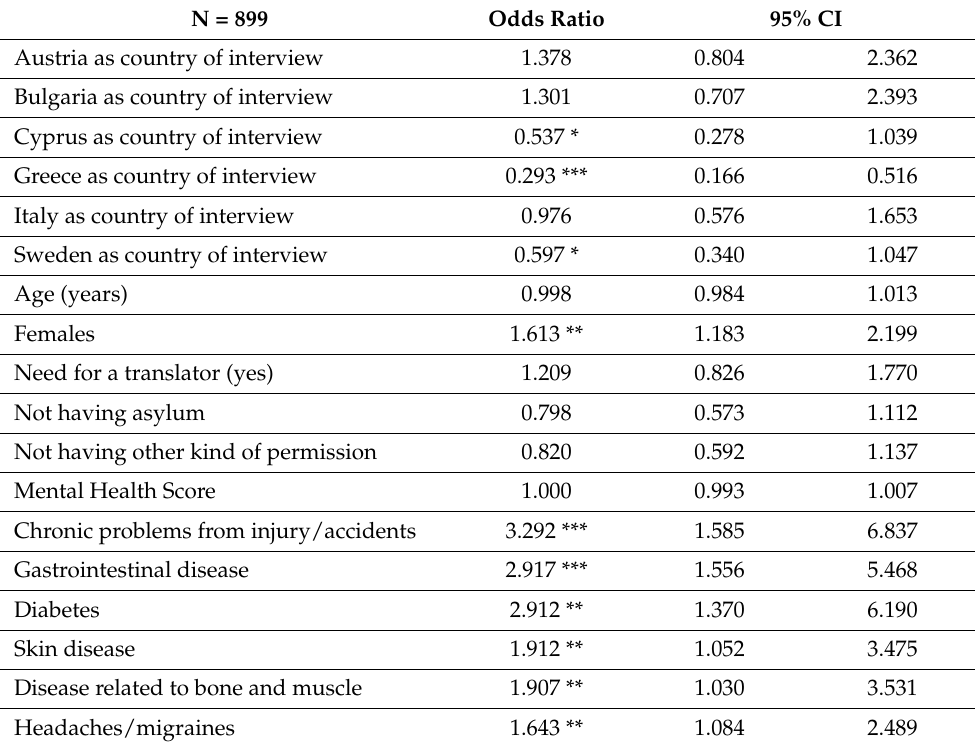
Table 7. Multivariable logistic regression investigating the impact of country of interview, need of a translator, permission to stay, and health status on access to healthcare services (dependent variable) in migrants and refugees. Migrants and refugees from Germany, France, and Malta were excluded from the analysis. N =